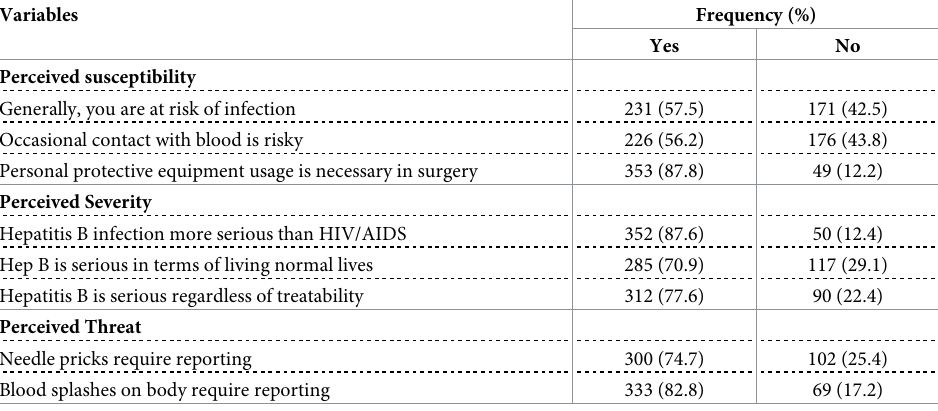
Table 3. Attitude towards hepatitis B infection prevention (n =